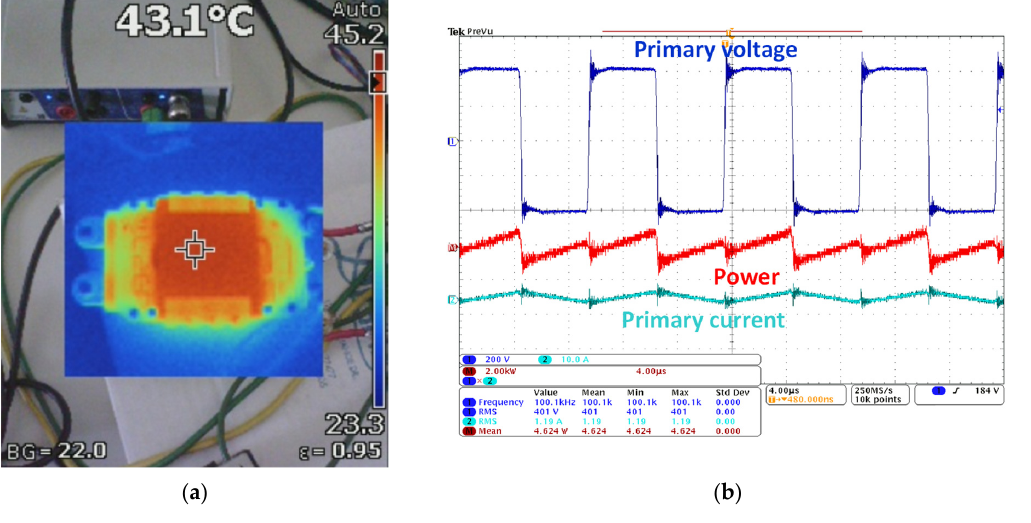
Figure 11. Thermal characterization—open circuit test: ( a ) temperature distribution; ( b ) voltage, current and power waveforms.